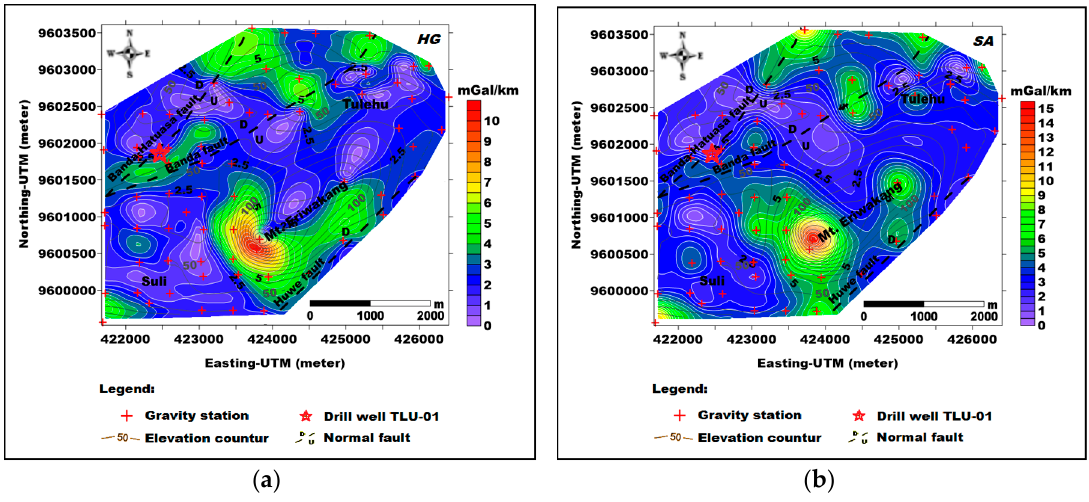
Figure 14. ( a ) the horizontal gradient; ( b ) 3D analytic signal of Suli and Tulehu geothermal regions.